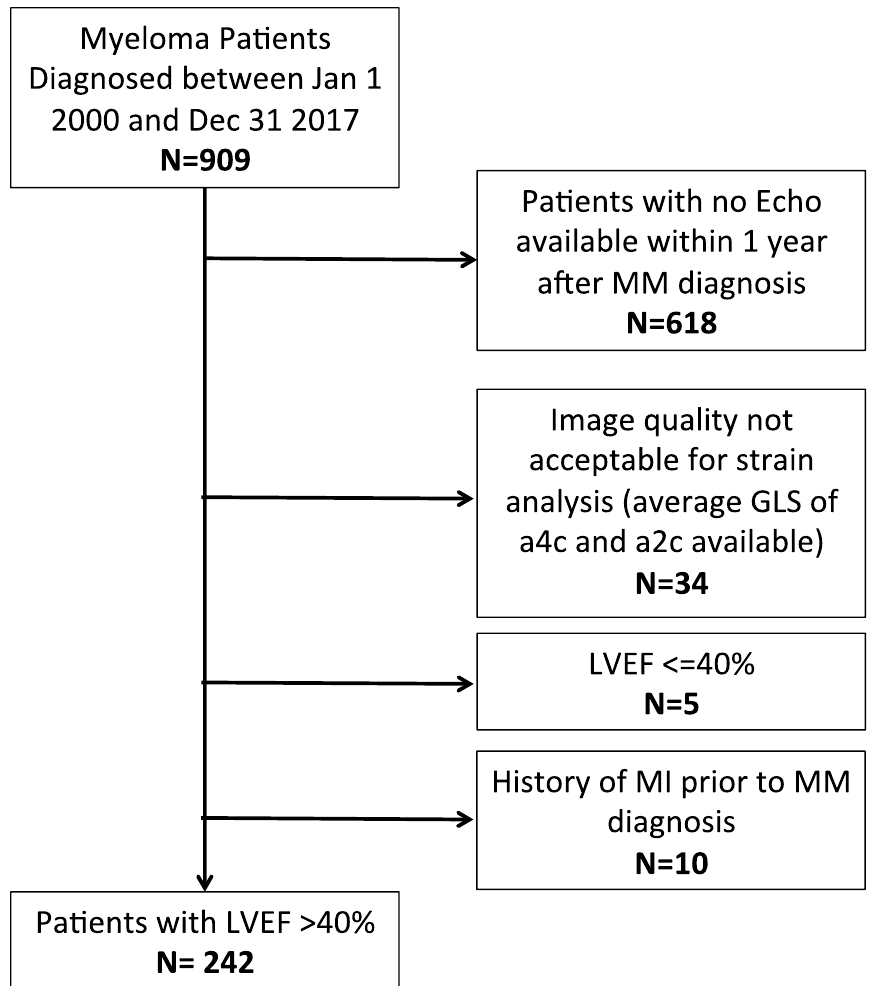
Figure 1. Patient selection flow diagram. GLS = global longitudinal strain; MM= multiple myeloma; LVEF = left ventricular ejection fraction.